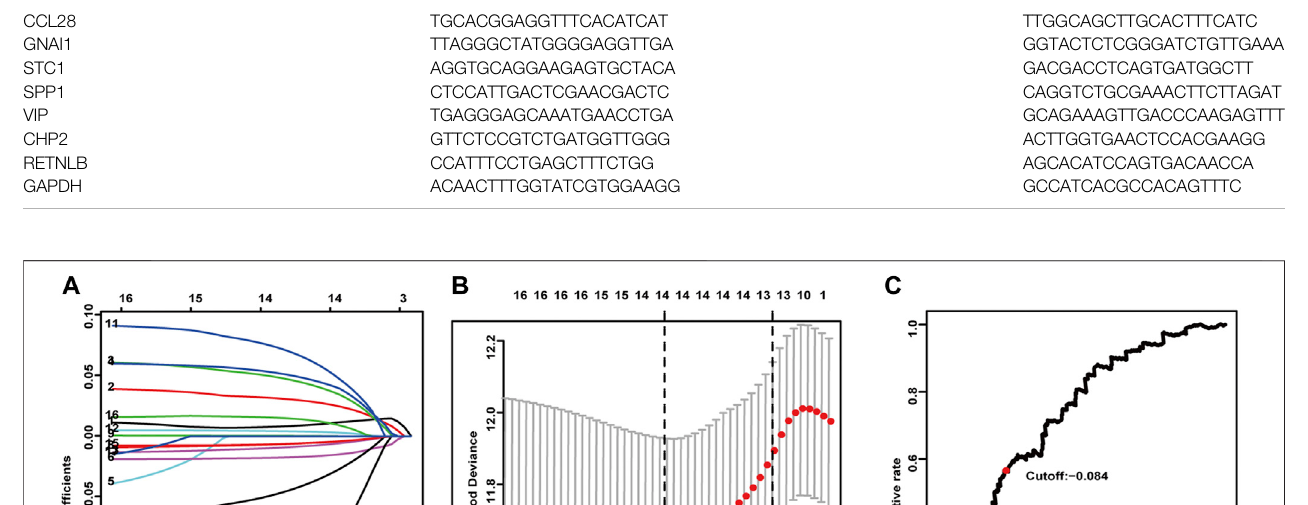
Frontiers in Cell and Developmental Biology |